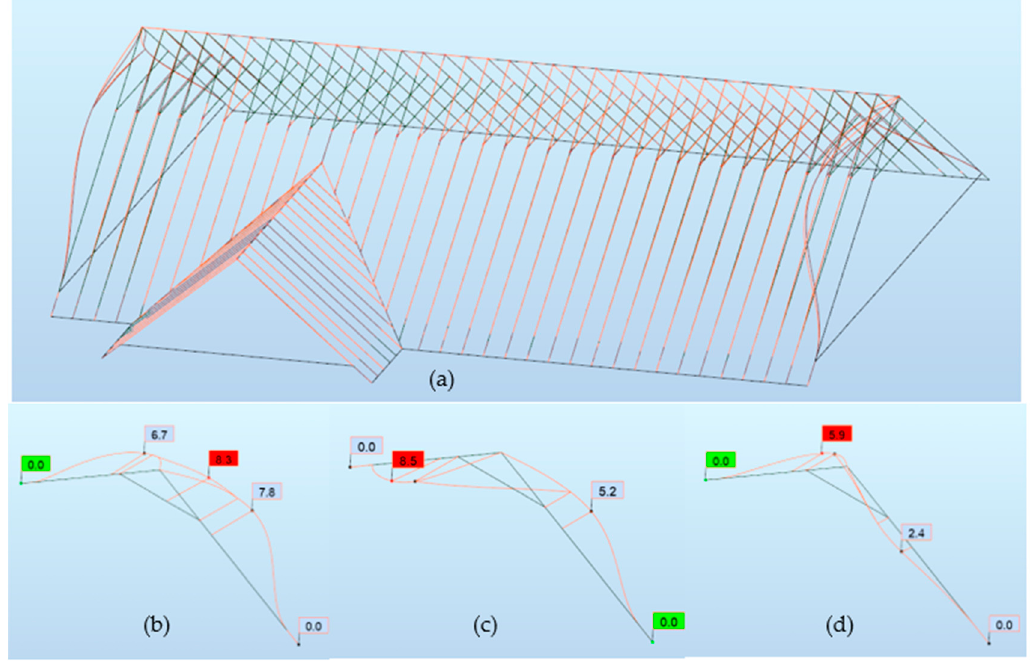
Figure 12. Deformation of the roof structure: ( a ) the entire roof structure, andthe most loaded pair of rafters (( b )—W1, ( c )—W2, ( d )—W3).